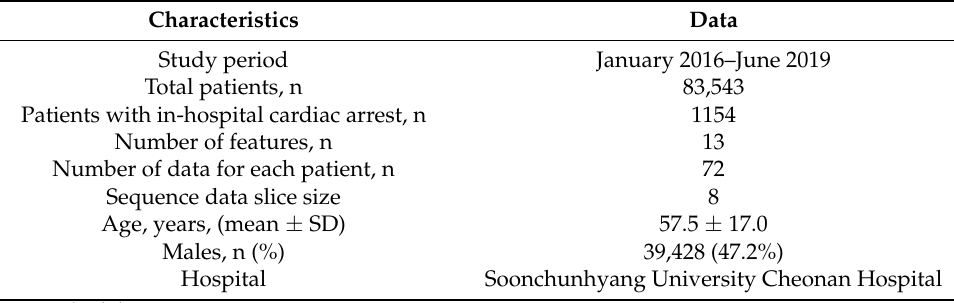
Table 1. Characteristics of the study population.